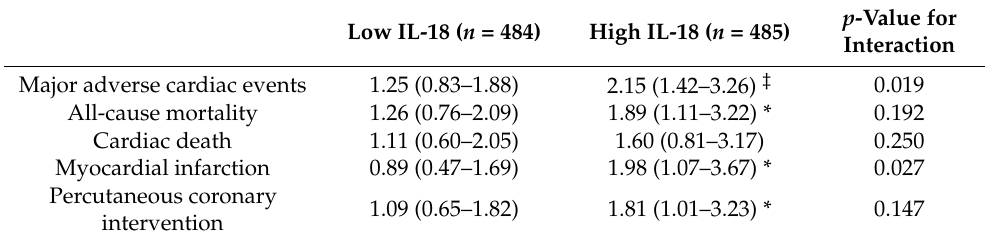
Figure 1. Cumulative incidence (%) of composite major adverse cardiac events (MACEs) according to the average BDNF methylation at baseline in patients with low ( A ) and high ( B ) interleukin-18 (IL-18) levels. Table 1. Associations of higher average BDNF methylation at baseline with long-term cardiac outcomes in patients with ACS according to the IL-18 level.